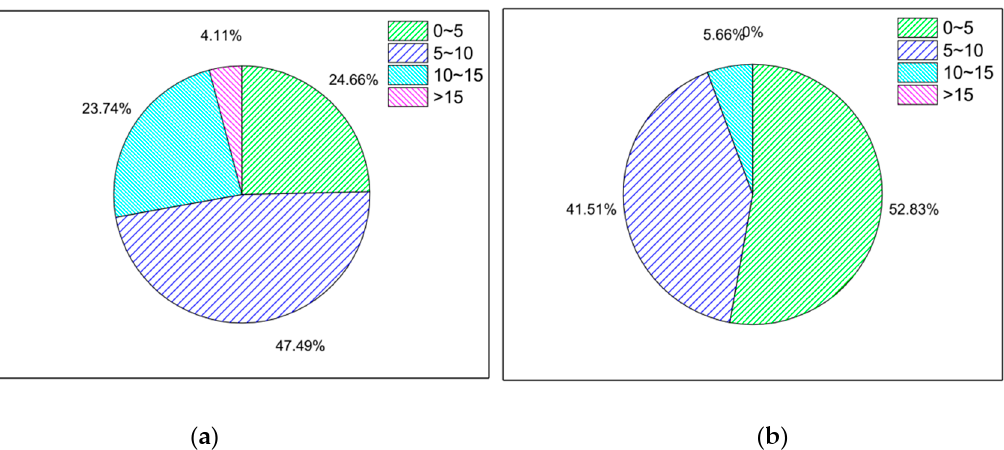
Figure 6. The pie distribution diagram of the standard deviation of passengers’ signal strength during the fine grain time. ( a ) In the bus. ( b ) Out of bus.